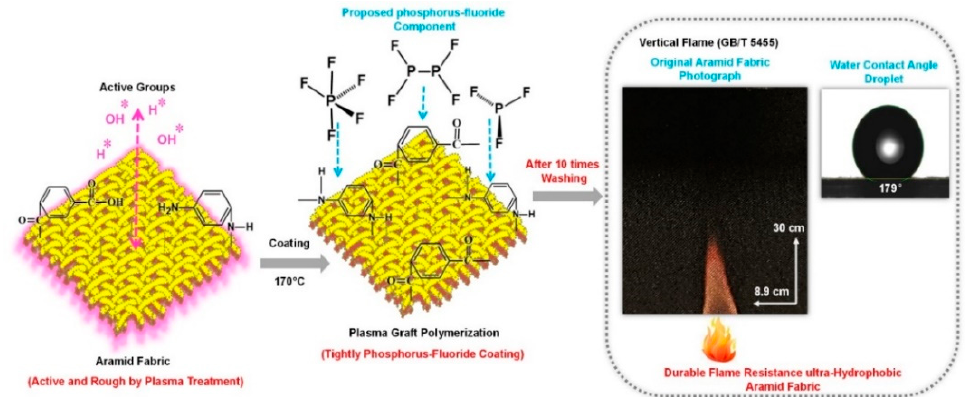
Figure 9. Suggested schematic for the mechanism of preparing a durable flame ‐ resistant and ultra ‐ hydrophobic aramid fabric